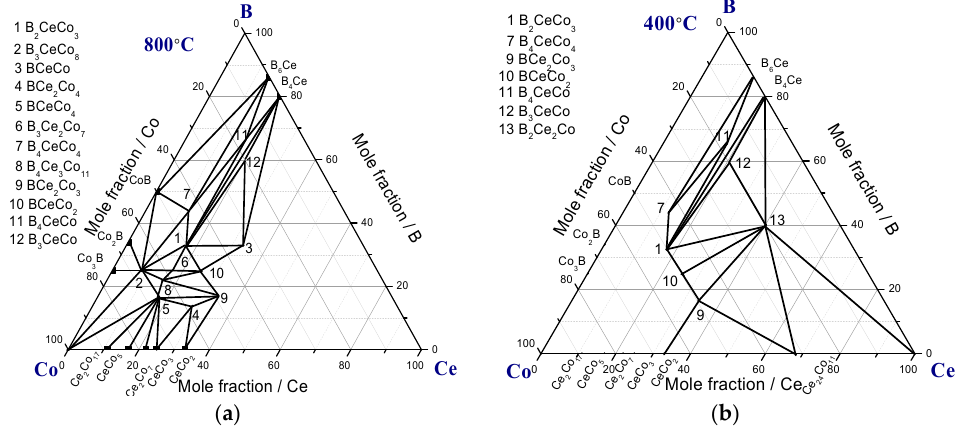
Figure 3. Isothermal section of B-Ce-Co ternary system at ( a ) 800 °C and ( b ) 400 °C redrawn from [13].